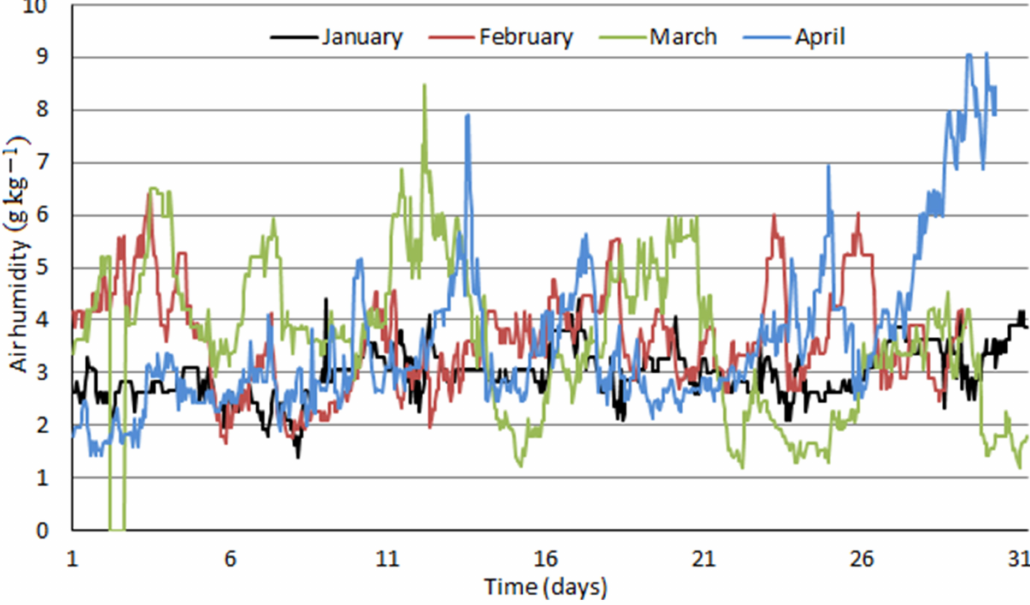
Figure 4. Hourly averages of air humidity in Košice—Center from January 2020 to April 2020.